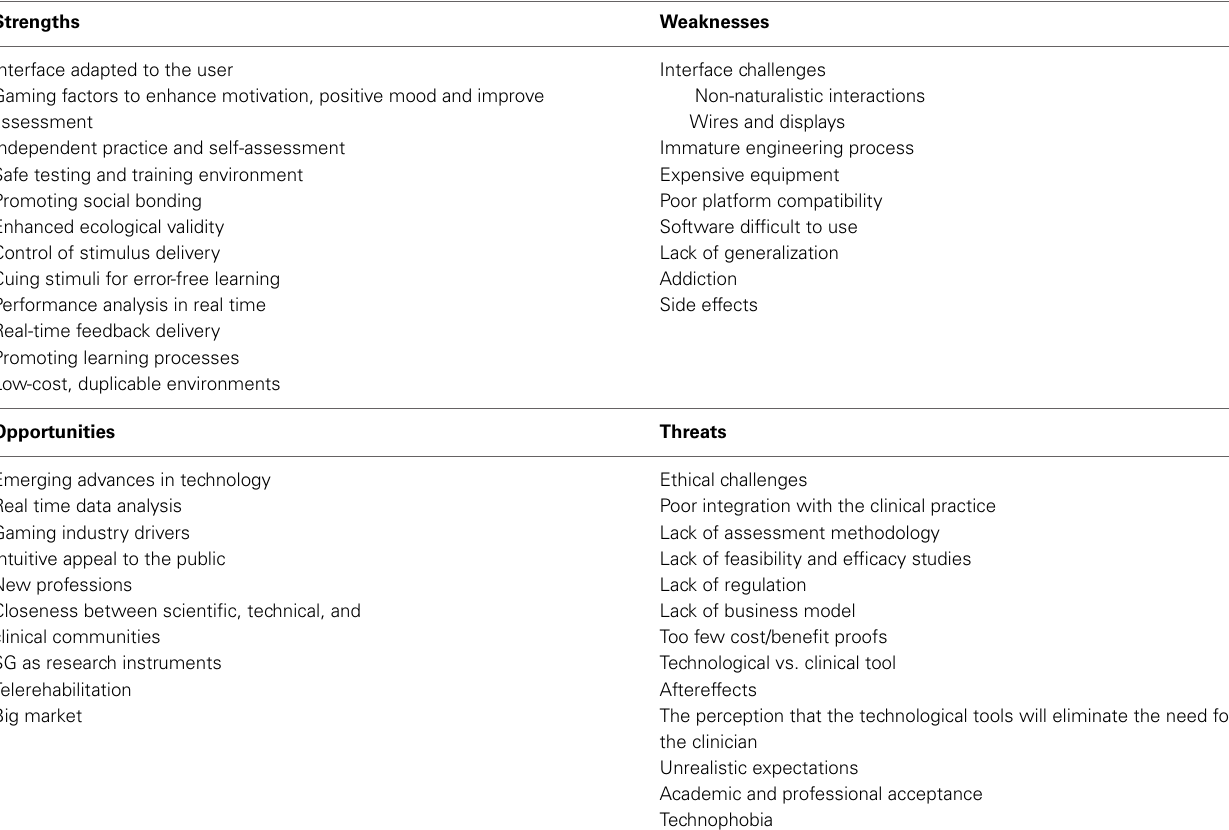
Table 2 | Summary of a SWOT analysis of the use of SG in ADRD.